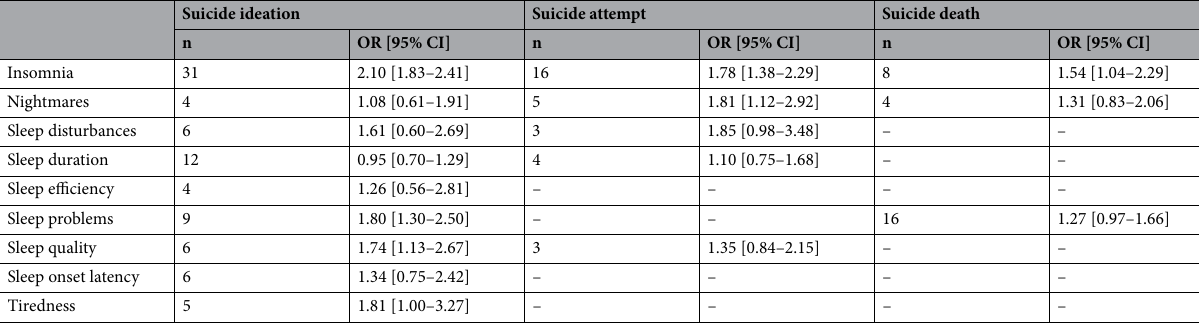
Table 1. Random-effects results for each broad predictor category.